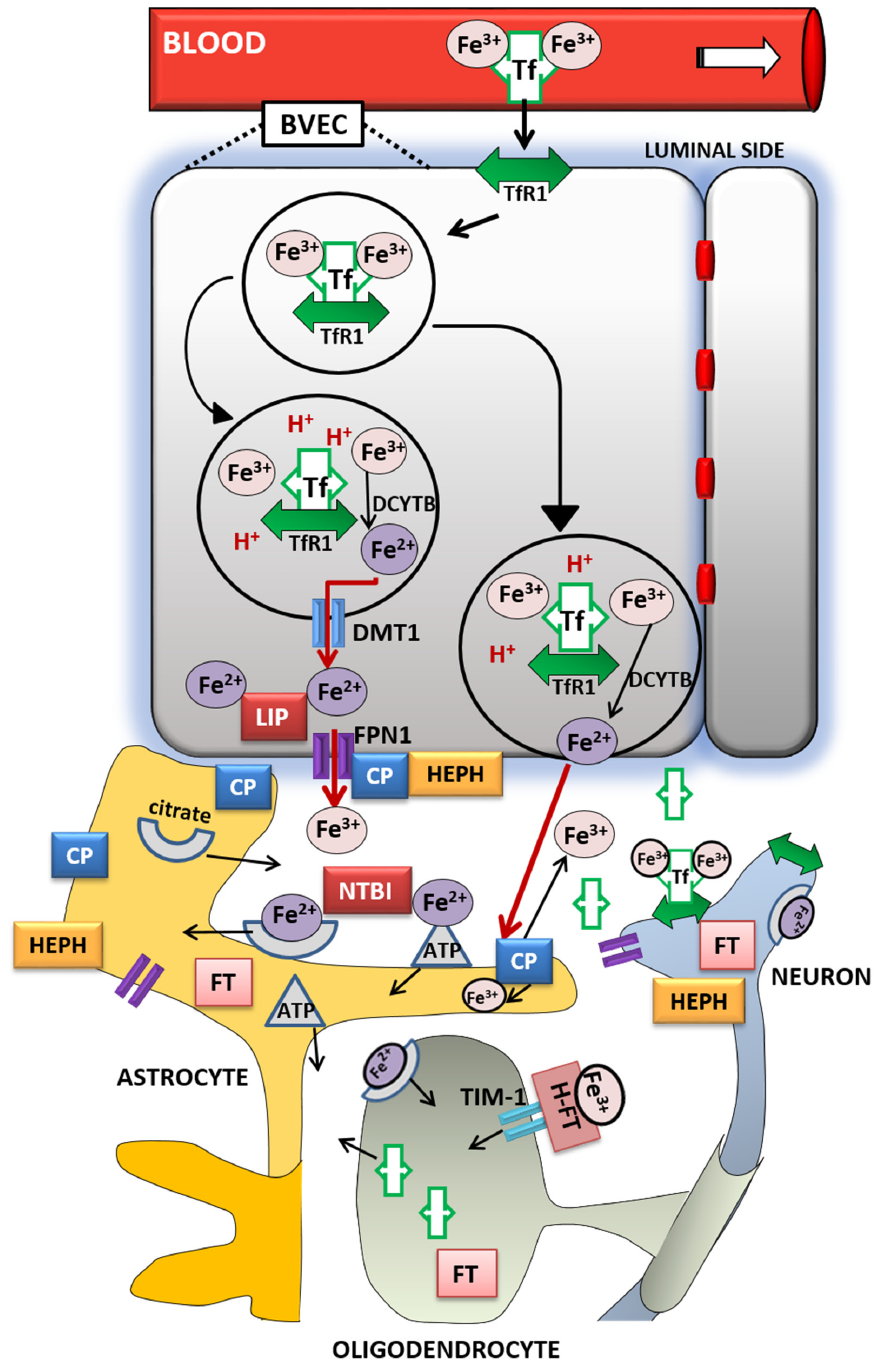
Figure 1. Iron transport inside the brain. A scheme of proposed transferrin-bound and non-transferrin bound iron transport pathways in the brain. Abbreviations : BVEC—blood vascular endothelial cell, Tf—transferrin, TfR1—transferrin receptor 1, Fe 3+ —ferric iron, Fe 2+ —ferrous iron, DCYTB—duodenal